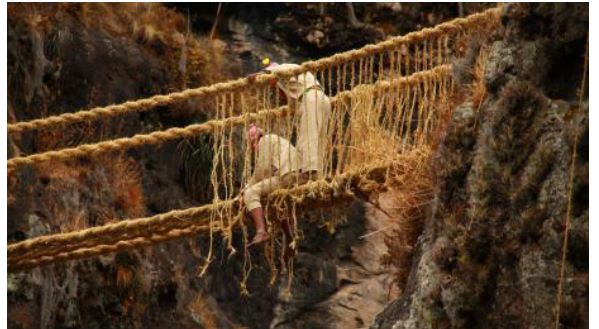
Figure 18. View of the Inca Bridge of Qeswachaca – Peru. © Knowledge and rituals associated with the annual renovation of the